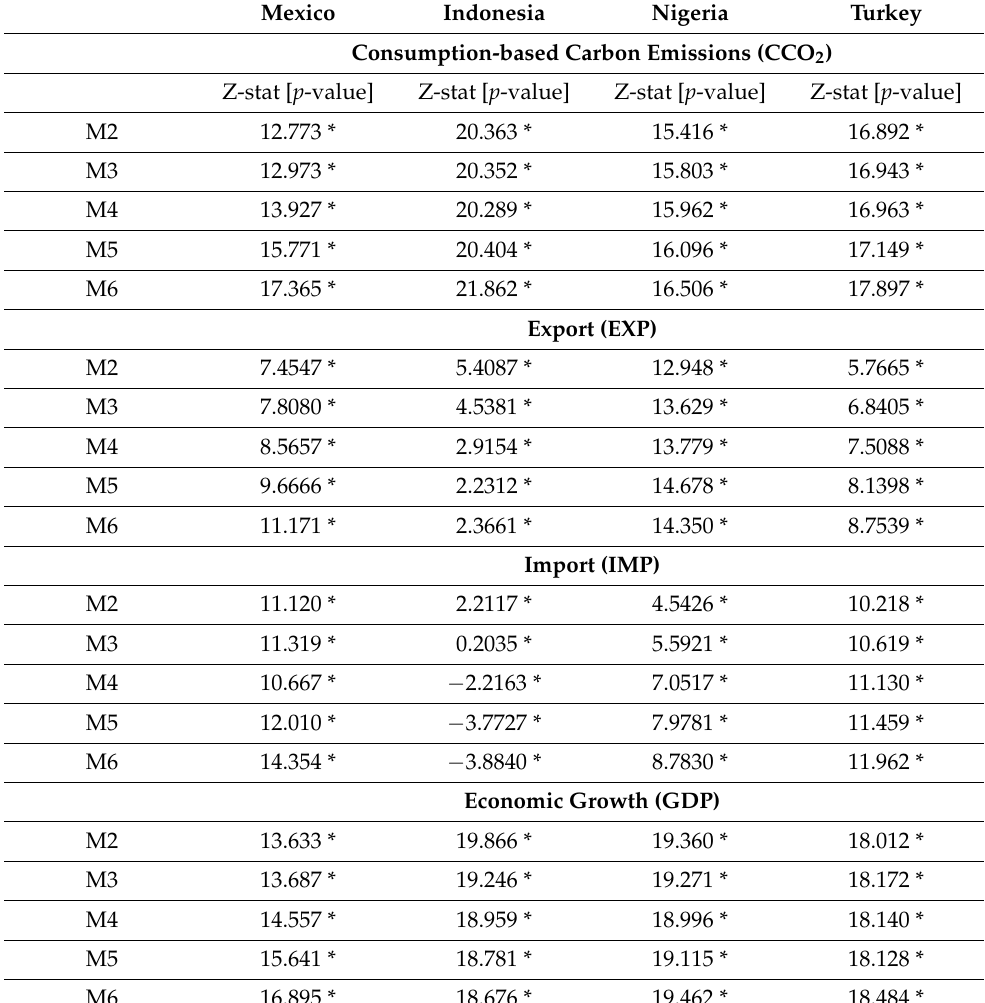
Table 4. BDS Test